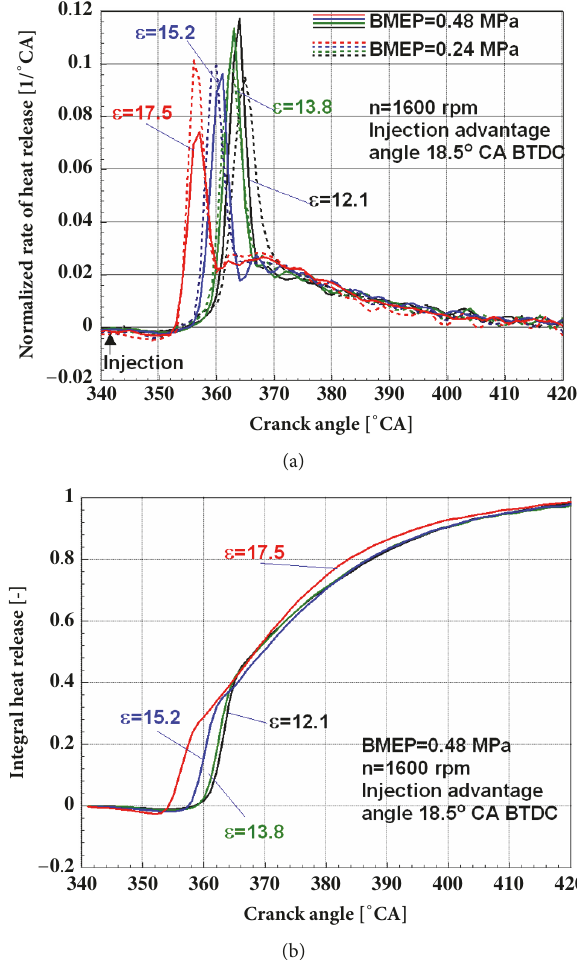
Figure4:(a)Normalizedrateofheatreleaseduringcombustionand (b) integral heat release vs. crank